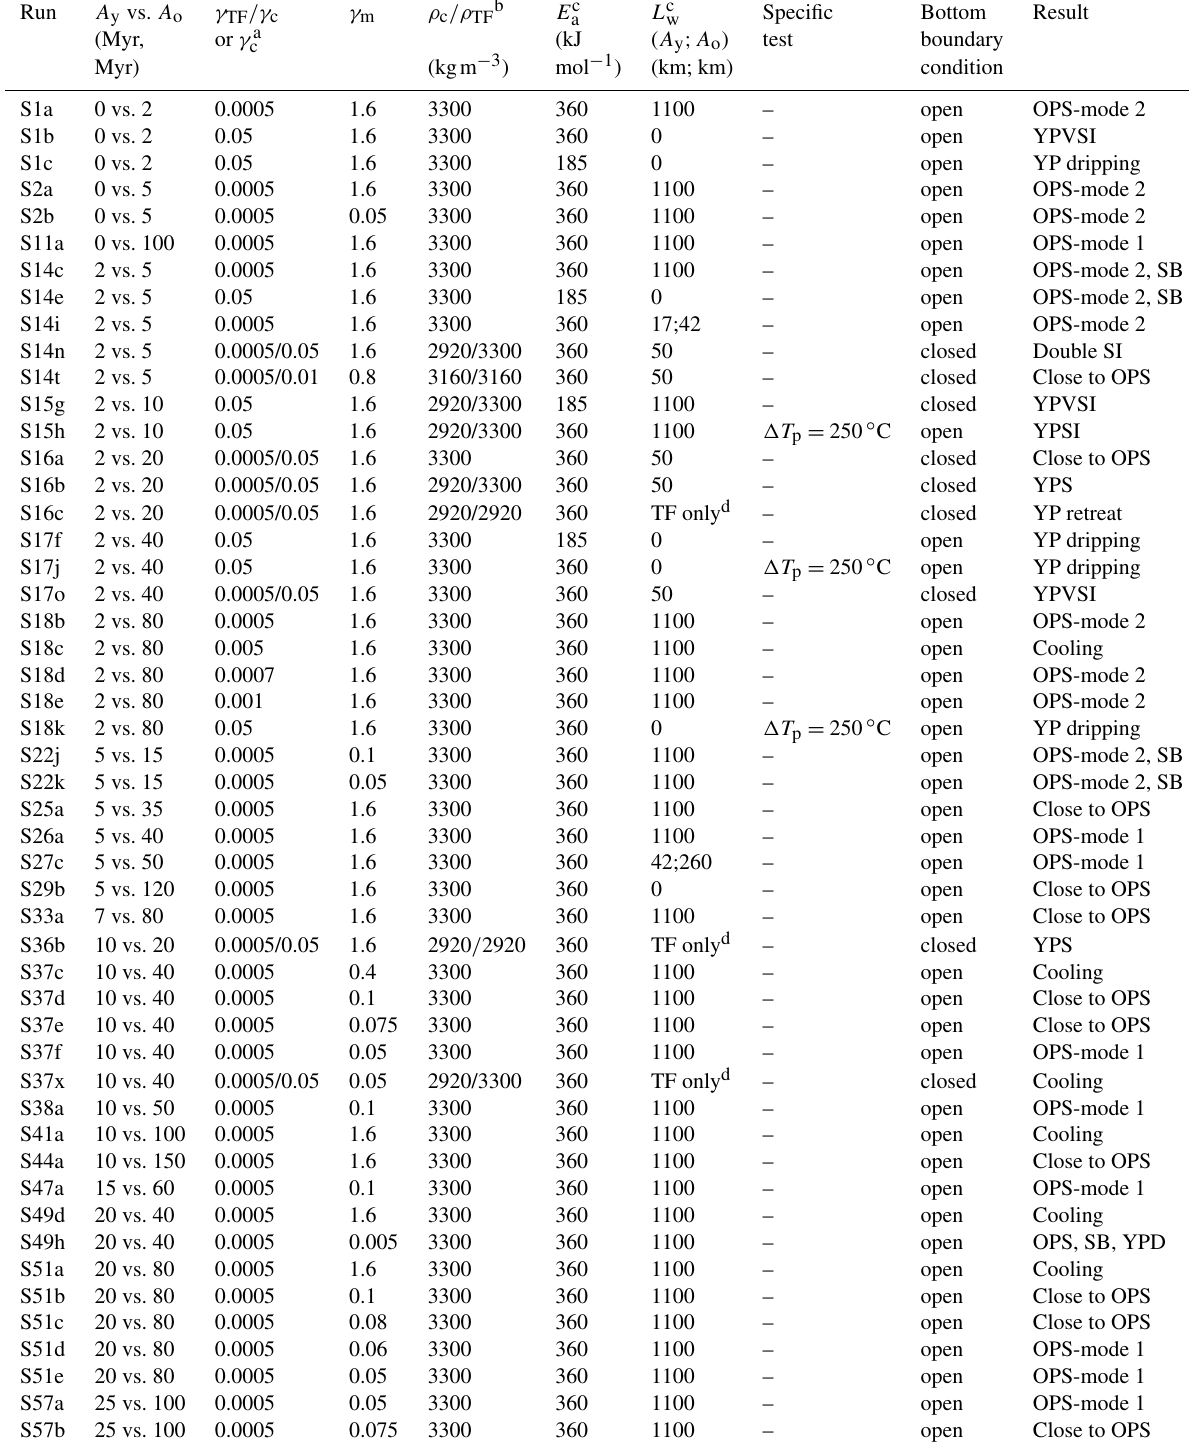
Table 3. List of simulations quoted in the text. See the data in the Supplement for the complete simulation list.